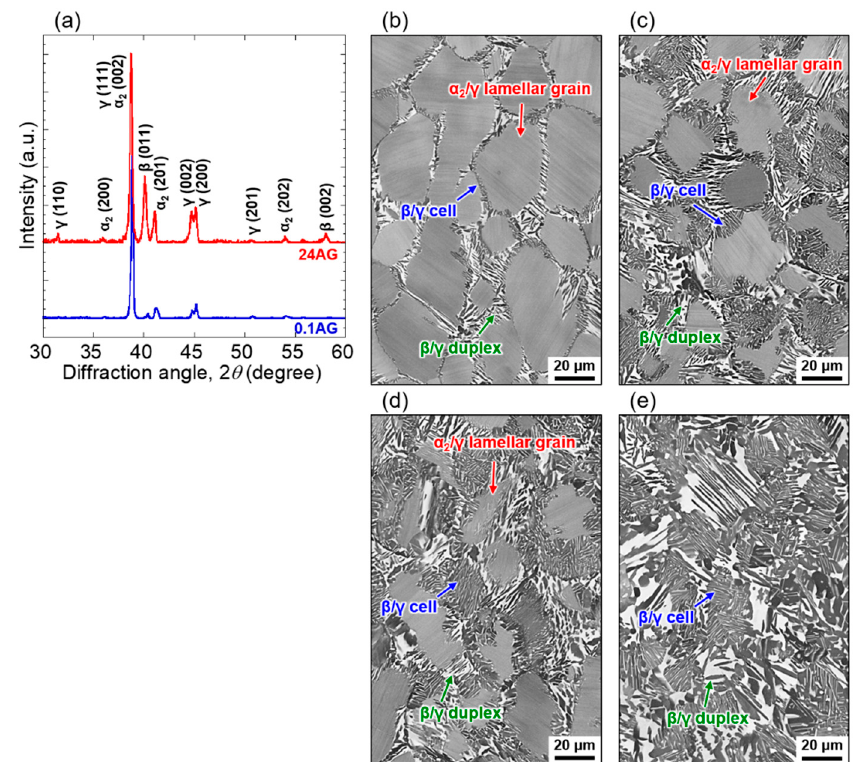
Figure 3. Typical XRD profiles of 0.1AG and 24AG ( a ) and SEM-BSE images of 0.1AG ( b ), 0.5AG ( c ), 1AG ( d ), and 24AG ( e ).